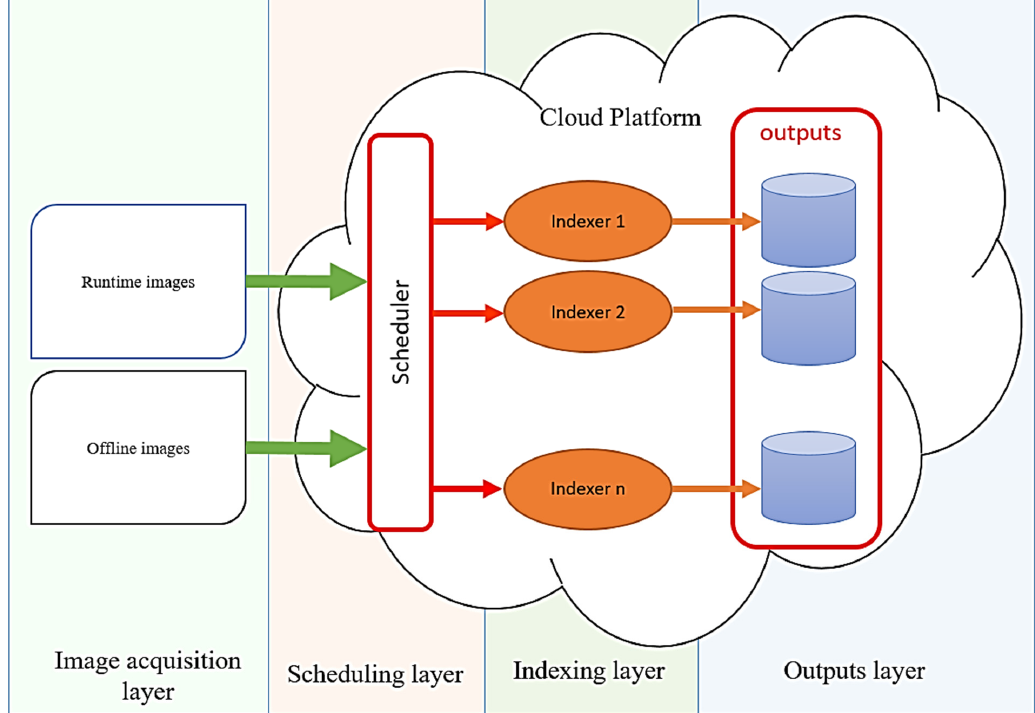
Figure 5. Distributed indexer.